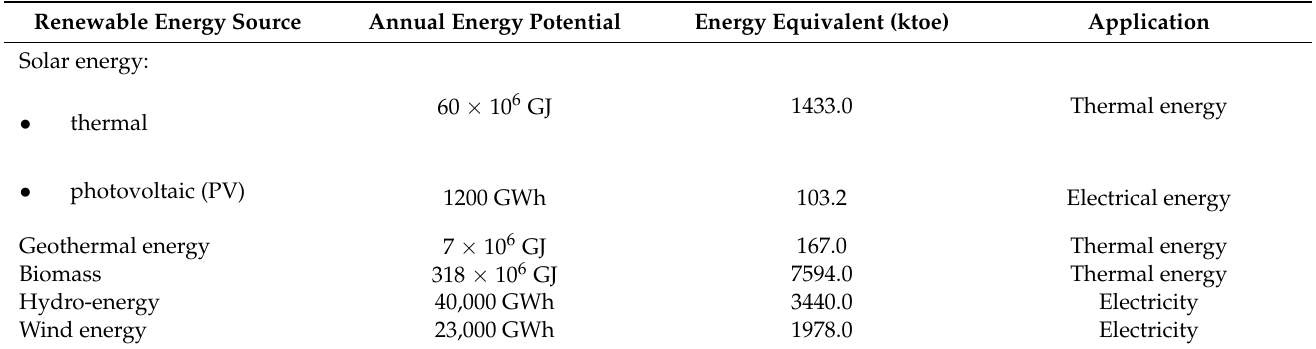
Table 3. Energy potential of each resource type [26].